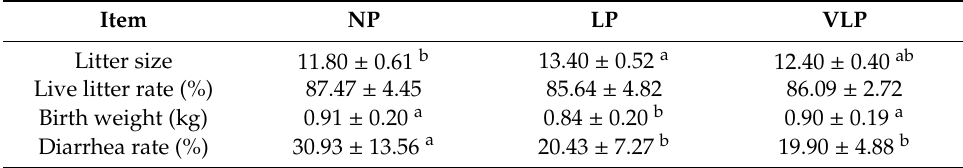
Table 2. E ff ect of protein level on litter sizes in Huzhu Bamei sows. Table 2. Effect of protein level on litter sizes in Huzhu Bamei sows.